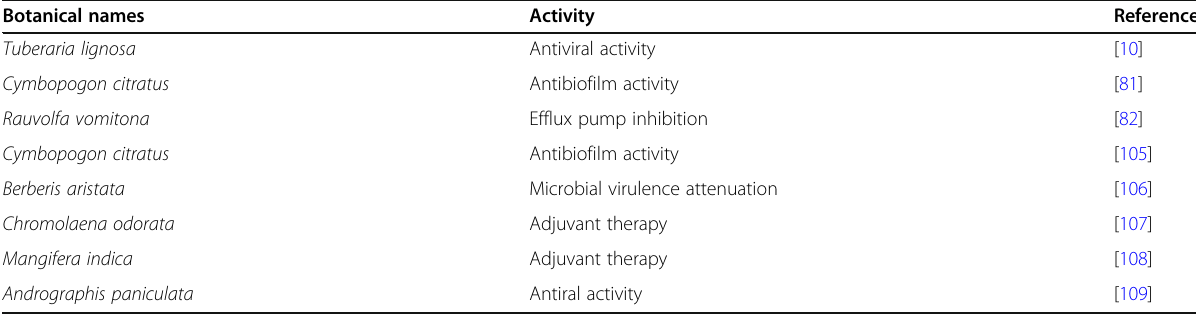
Table 3 Medicinal plants and their antimicrobial intervention Botanical names